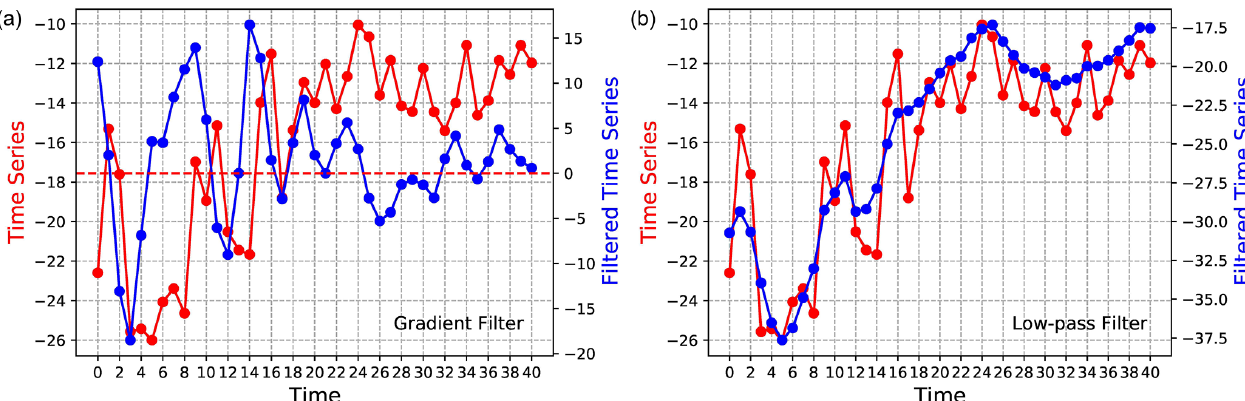
Figure 3. The two graphs illustrate the application of one-dimensional (1D) filters to time series that can be used by convolutional layers of a TempCNN for extraction of temporal features. The red line represents the original time series, while the blue line denotes the filtered time series: (a) a curve that resembles floating ice transformed by a gradient filter; the red dashed line indicates the origin of the filtered time series; the filtered series has positive values where the value of the original series is increasing, while the filtered series has negative values where the value of the original series is decreasing; (b) a curve resembling floating ice transformed by a low-pass filter.